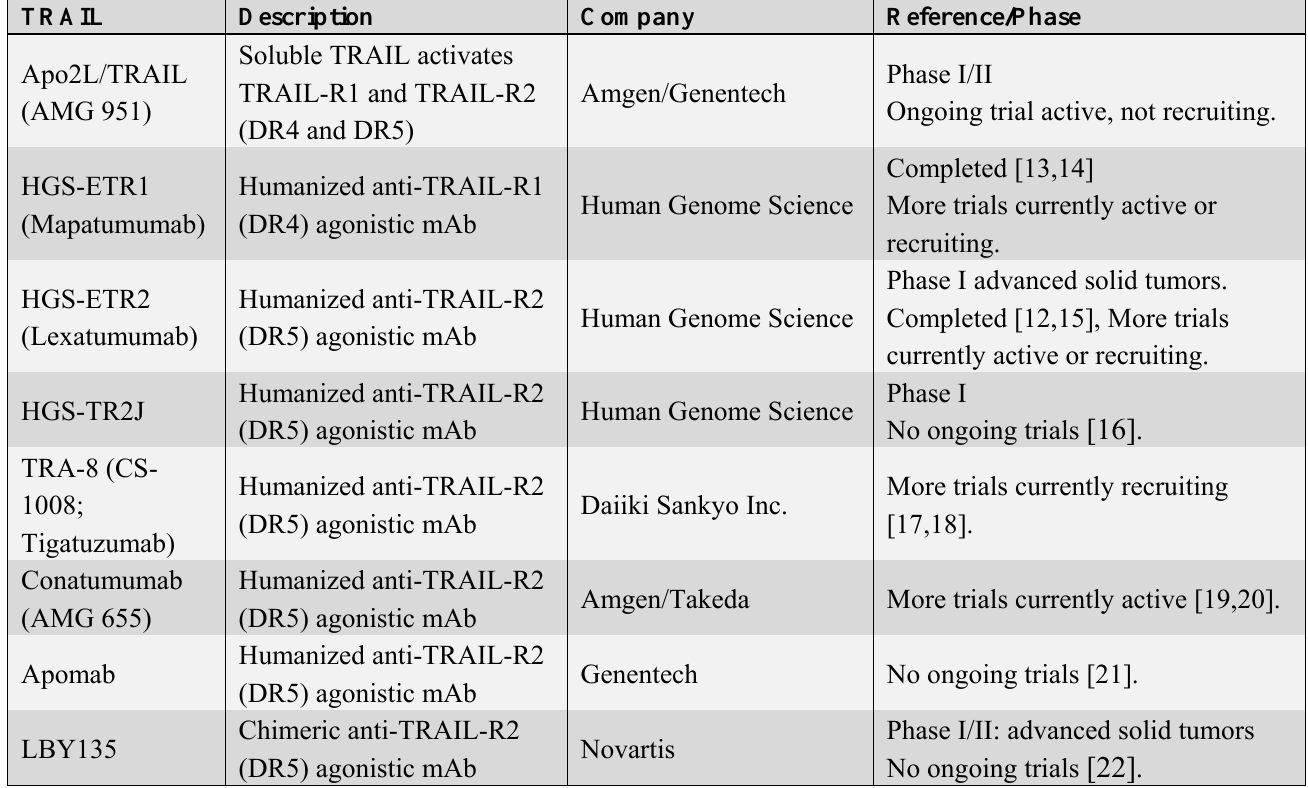
Table 1. TRAIL targeting